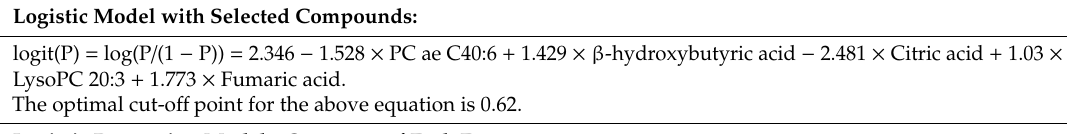
Figure 5. ROC curve generated by the logistic regression models for NSCLC patients at early stages (stage I + II). ( a ) ROC curve of the metabolites-only model; ( b ) ROC curve of the metabolites + smoking history model. ROC curves and their 95% CI on the discovery set are shown in blue. ROC curves obtained from the validation set are colored in red. Table 6. Logistic regression based optimal model for stages I + II NSCLC detection: metabolites only. Logistic Model with Selected